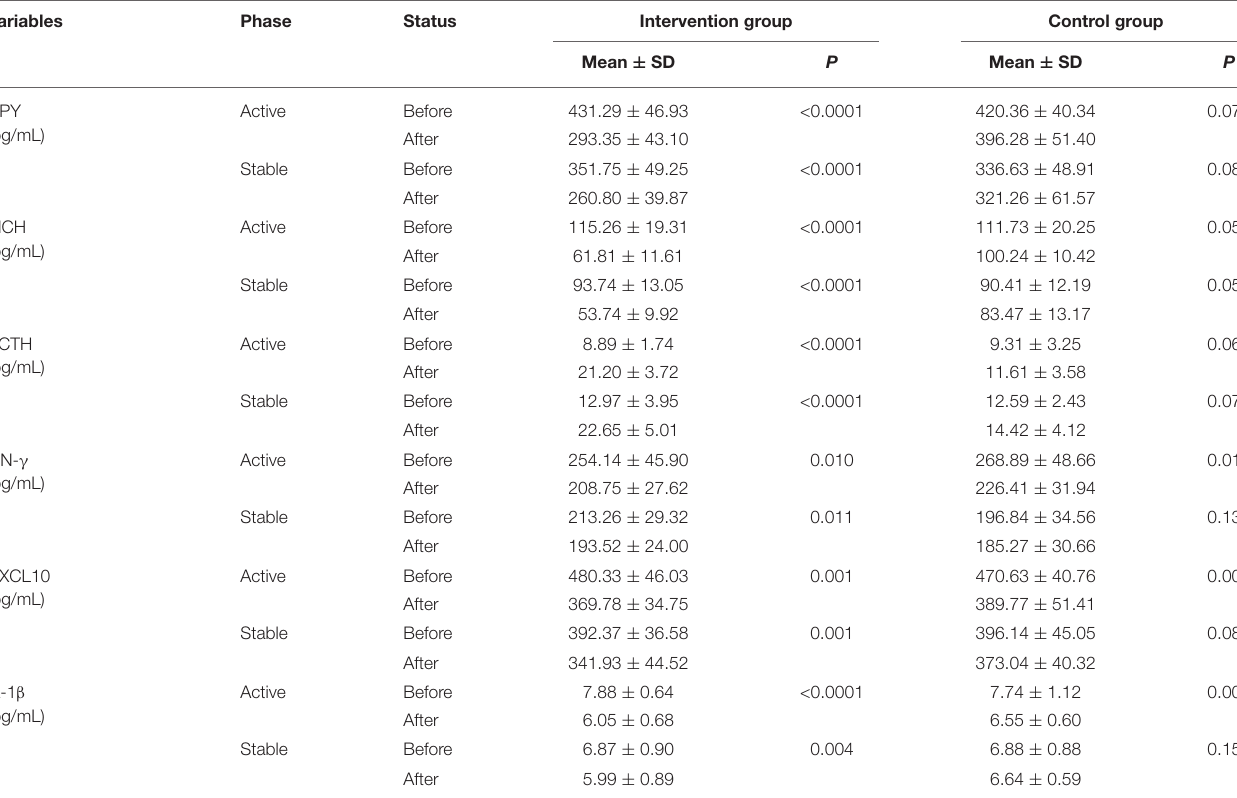
TABLE 4 | Serum levels of NPY, MCH, ACTH, IFN- γ , CXCL10, IL-1 β in patients with vitiligo of active ( n = 10) and stable ( n = 20) phases in both the intervention and control groups.